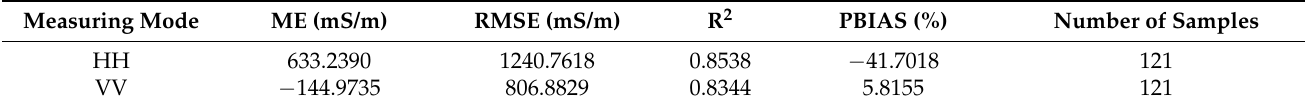
Table 13. Statistical data for accuracy assessment of OCK